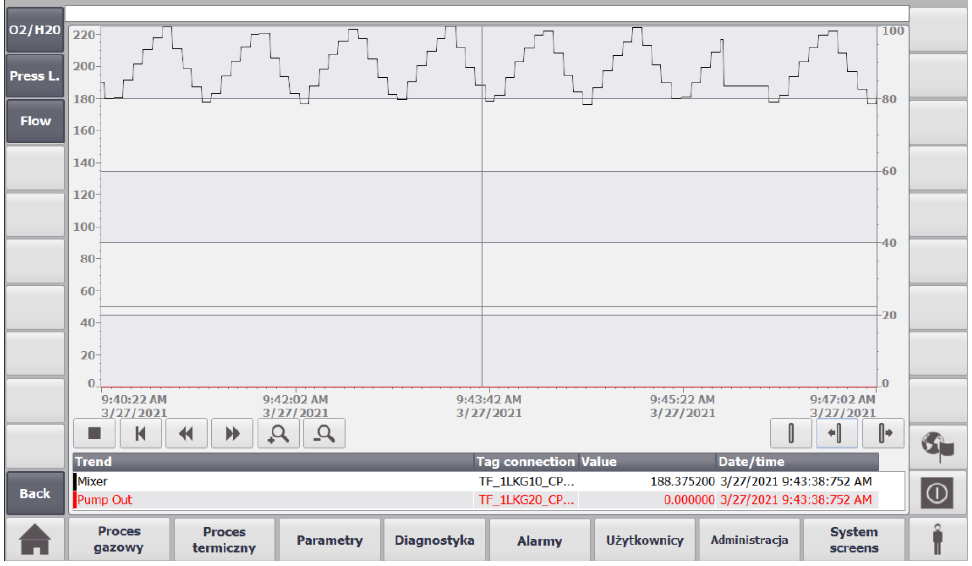
Figure 10. The digital twin SCADA gas process diagnostics screen.